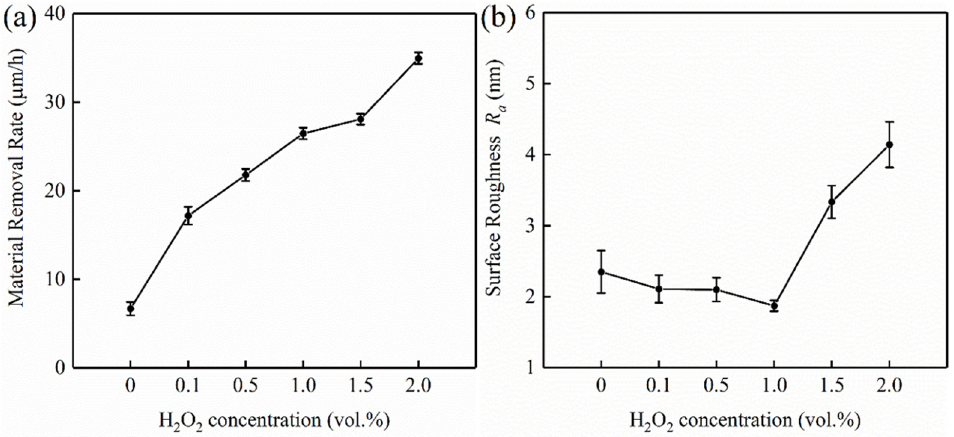
Figure 8. Effect of H 2 O 2 concentrations on removal rate and surface roughness: ( a ) material removal rate; ( b ) surface roughness.